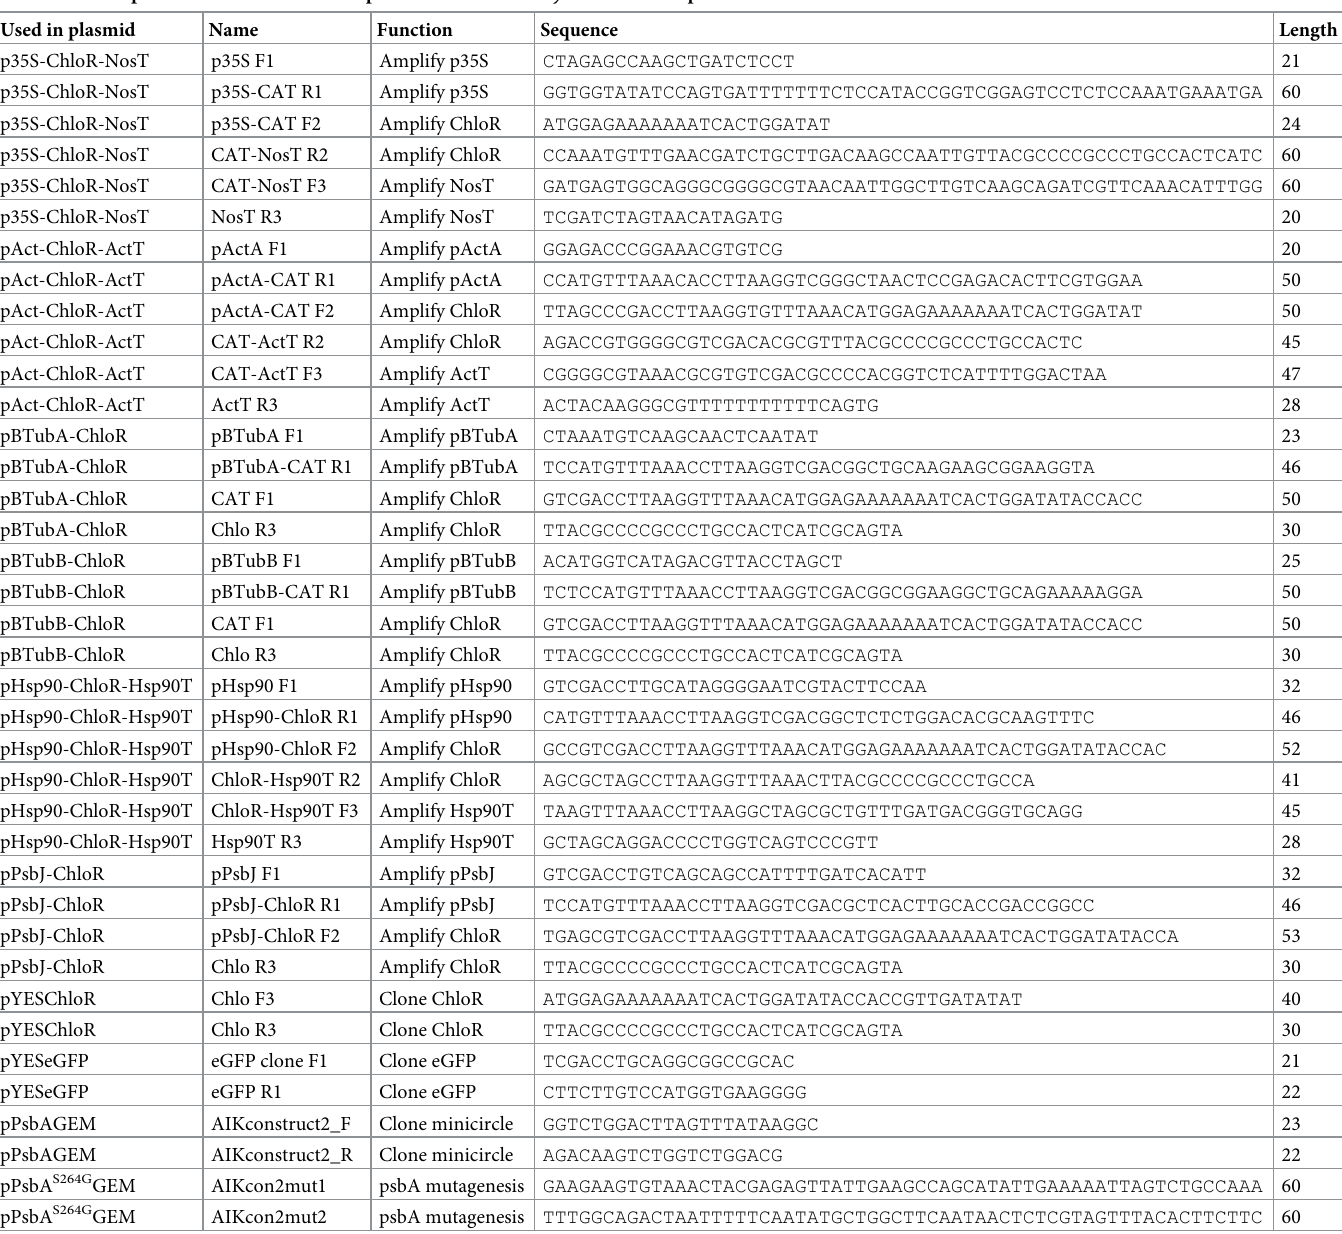
Table 4. List of primers used to construct expression cassettes for Symbiodinium expression vectors. Used in